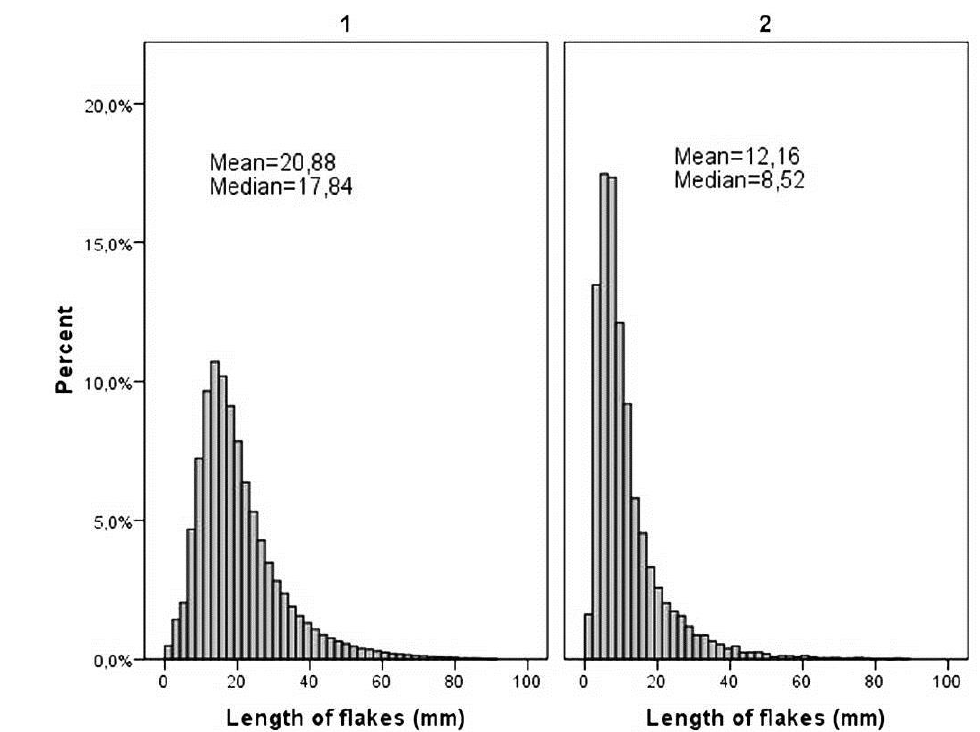
Figure 11. Comparison of flake length distributions in the Fofanovo XIII assemblage and the experimental assemblage. 1 – assemblage from excavations, 2 – experimental assemblage